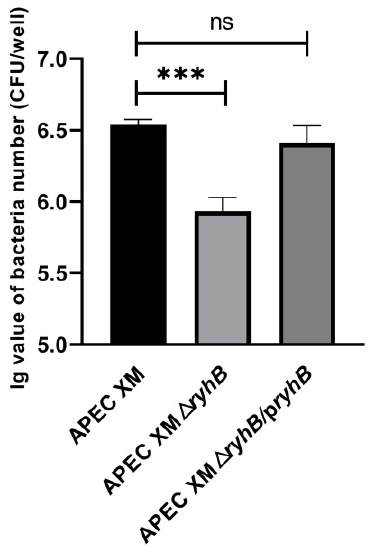
Figure 2. Adherence to bEnd.3 cells by APEC XM, APEC XM Δ ryhB and APEC XM Δ ryhB /p ryhB . The data were analyzed with one-way ANOVA and are expressed as the mean ± standard error of the mean for three independent experiments. (***, p < 0.001; ns, p > 0.05).